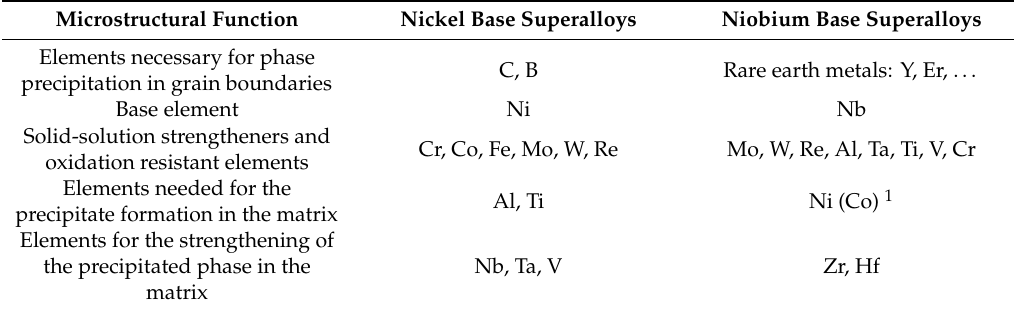
Table 1. Comparative composition between Ni and Nb superalloys (adapted and completed from [31]). Microstructural